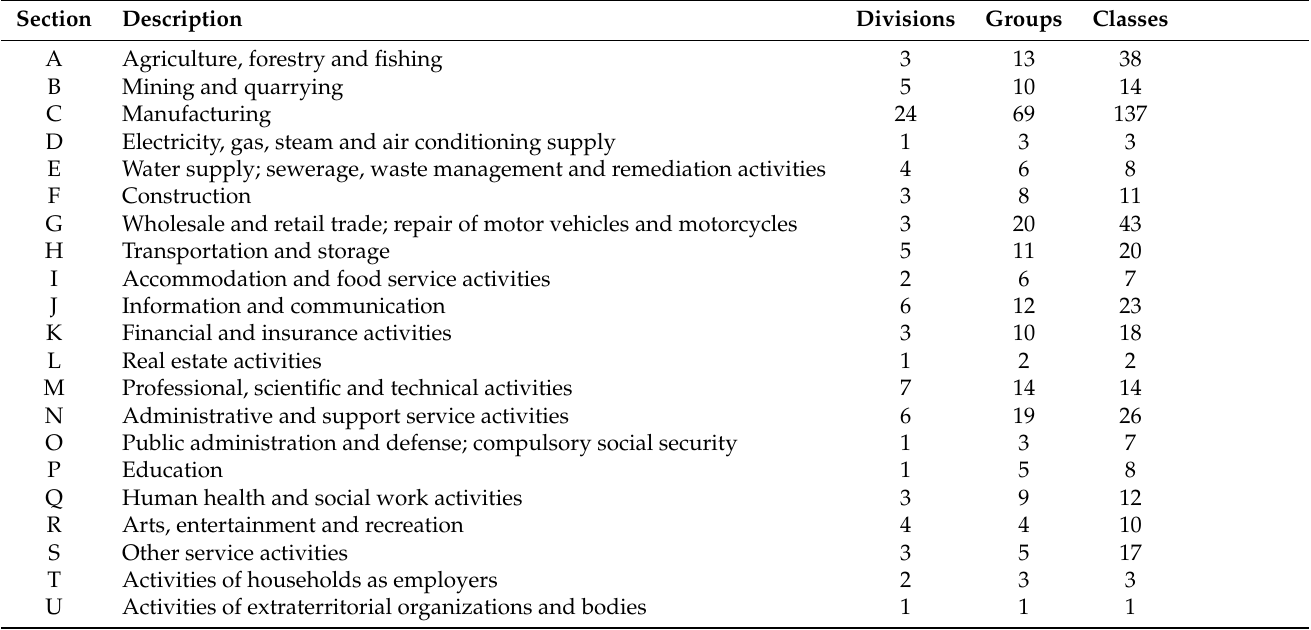
Table 1. Broad structure of ISIC4 classification of economic activities [2].